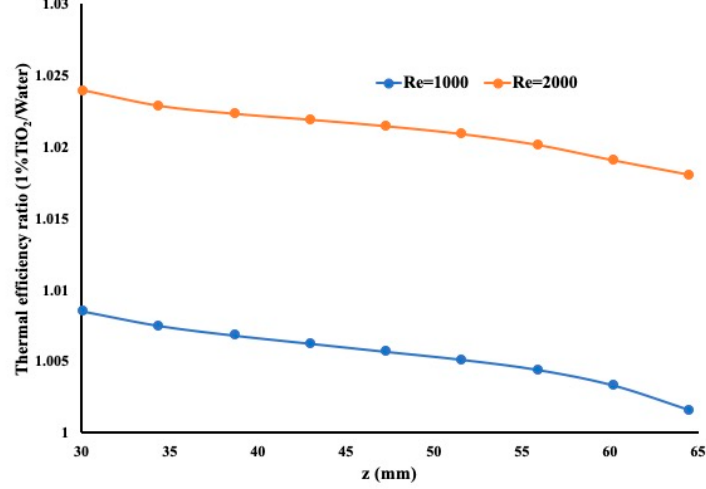
Figure 11. Thermal efficiency ratio between nanofluid and water (porous insert).